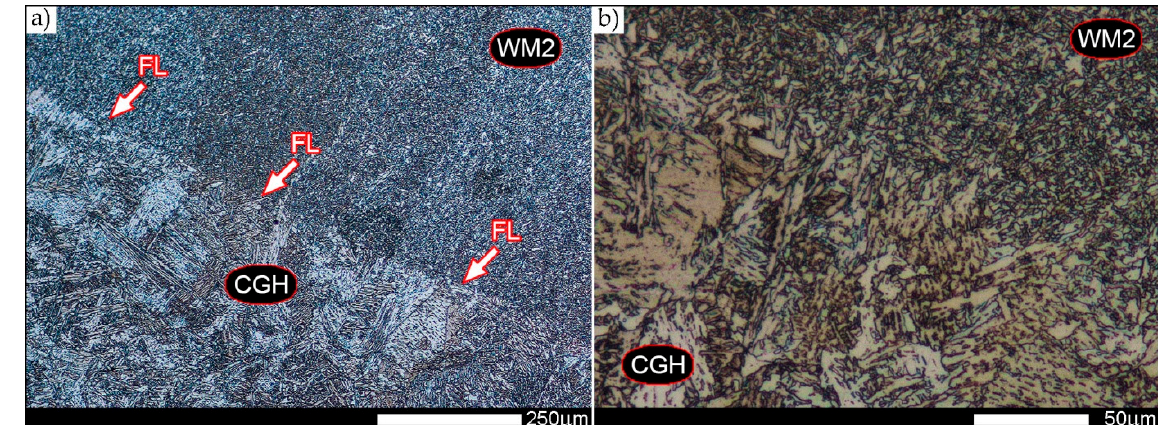
Figure 9. Microstructure of a welded joint of Hardox 450 in delivery state (directly after welding)—FL zone shown in Figure 2a. ( a ) 100 × ; ( b ) 500 × . Clearly visible—narrow—fusion line, mainly consisting of sorbite and troostite structures. A very clear microstructure growth can be observed directly under the fusion line. FL—fusion line, WM2—weld metal zone, CGH(AZ)—coarse grain zone. Light microscopy, etched with 3% HNO 3 .